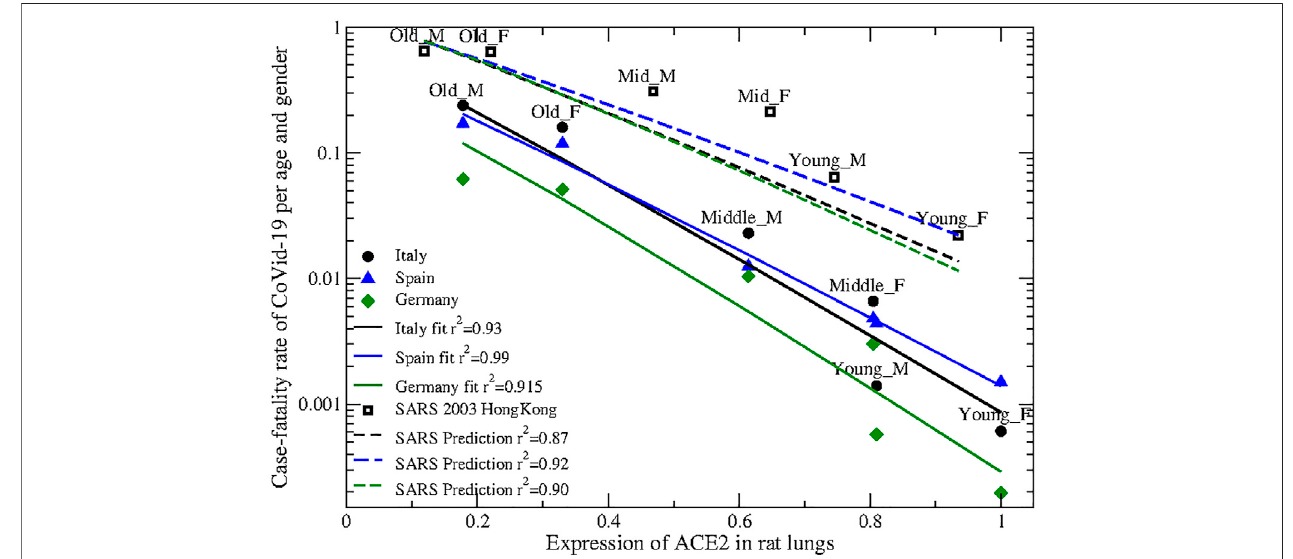
FIGURE2| Expression of the ACE2 protein in rats lung (horizontal axis), normalized so that the highest expression is one, vs. case fatality rate (vertical axis) of SARS-CoV-2 (Circles: Italy; triangles: Spain; diamonds: Germany) and SARS 2003 (open squares) in three age classes (young 0 – 29, middle-age 30 – 59 and old > 59) and two sexes. The solid lines represent best fi ts to the mathematical model CFR (cid:1) exp (− a ACE2 + b a (cid:1) 7 . 6 ± 0 . 5 , b (cid:1) 1 . 1 ± 0 . 4 , c (cid:1) 0 . 52 , r 2 (cid:1) 0 . 93 (Italy), a (cid:1) 6 . 9 ± 0 . 5 , b (cid:1) 1 . 1 ± 0 . 5 , c (cid:1) 0 . 85 , r 2 (cid:1) 0 . 99 (Spain) and a (cid:1) 8 . 7 ± 1 , b (cid:1) 2 . 0 ± 1 , c (cid:1) 1 . 4 , r 2 (cid:1) 0 . 91 (Germany). The parameter c was not fi tted but determined so that the relative error on the parameters a and b equals 50%. The dashed lines represent predictions with the parameters a and b fi tted to SARS-CoV-2 rescaled with the ratio between the binding rate constants of SARS and SARS-CoV-2 (see text) and parameter c fi tted to the 2003 SARS CFR in Hong-Kong, yielding a (cid:1) 5 . 7 , b (cid:1) 0 . 93 , c (cid:1) − 0 . 01 , r 2 (cid:1) 0 . 87 (from Italy ’ s fi t), a (cid:1) 5 . 1 , b (cid:1) 0 . 97 , c (cid:1) − 0 . 10 , r 2 (cid:1) 0 . 92 (from Spain ’ s fi t) and a (cid:1) 6 . 5 , b (cid:1) 1 . 7 , c (cid:1) − 0 . 58 , r 2 (cid:1) 0 . 90 (from Germany ’ s fi